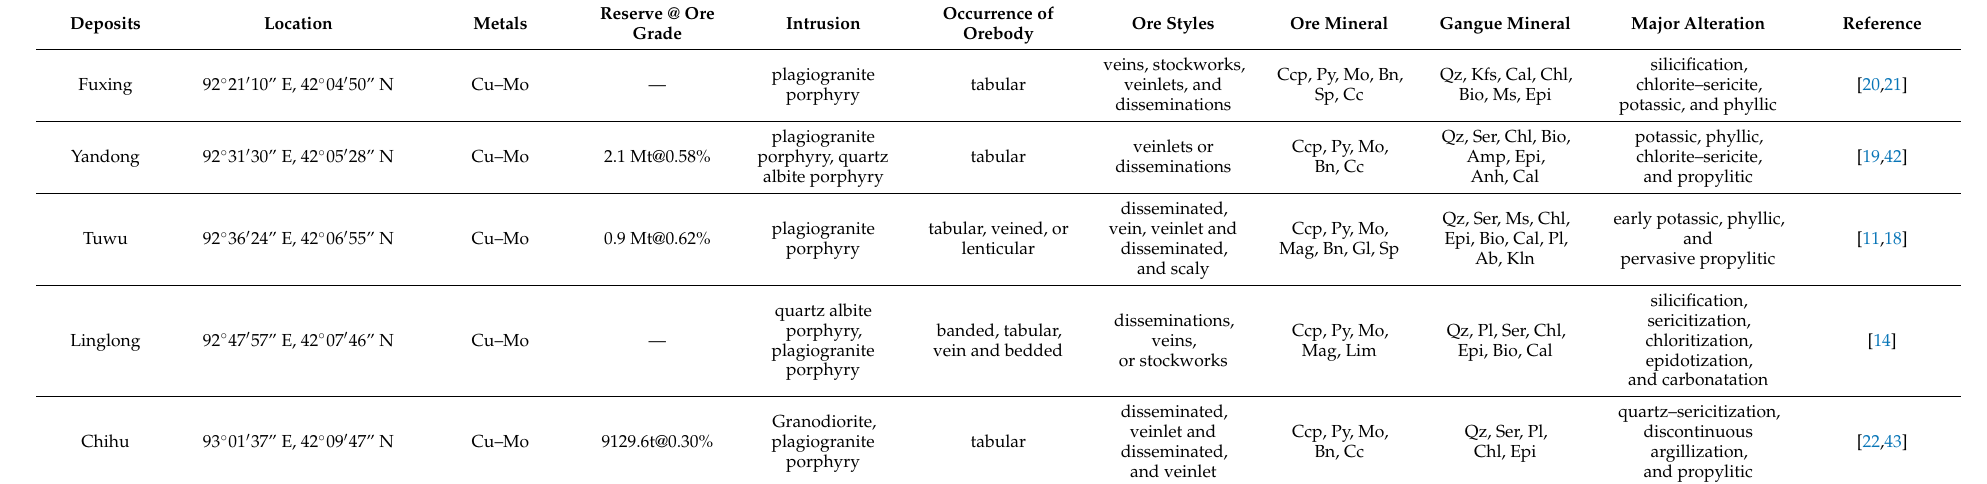
Table 1. Geological characteristics of five deposits in the Tuwu–Yandong porphyry Cu belt, Eastern